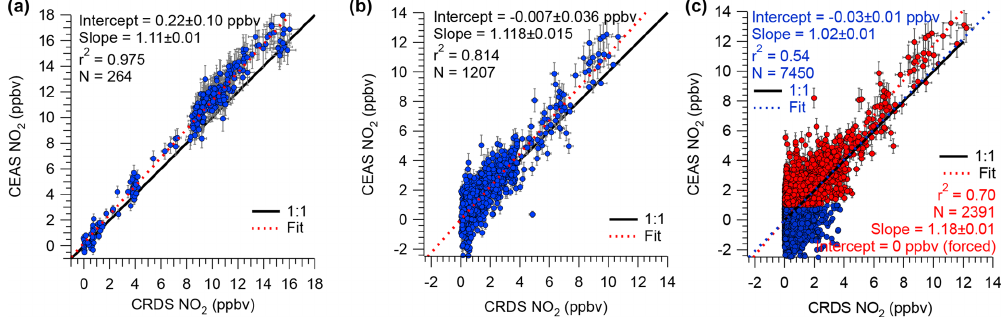
Figure 7. Scatter plots and straight-line fits of IBBCEAS and CRDS NO 2 mixing ratios for (a) standard additions and calibrations, (b) ambi- ent air measurements on 18–19 July 2015, and (c) ambient air measurements of the entire campaign. For the fit line shown in red, IBBCEAS retrievals with NO 2 mixing ratios < 1ppbv were excluded. All data were averaged to 60s.